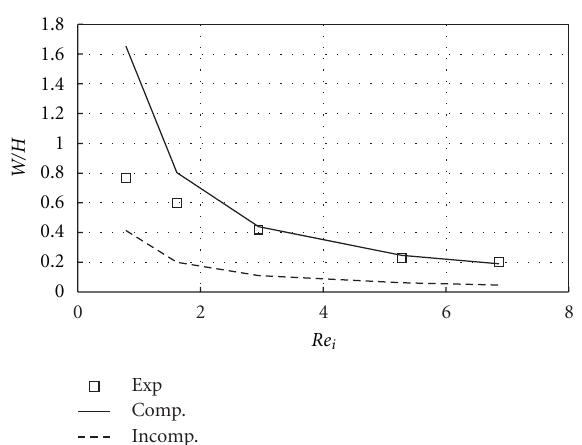
Figure 11: Ratio of maximum flame width to visible flame height as a function of injection Re for a single 2D jet fired with 100% CH 4